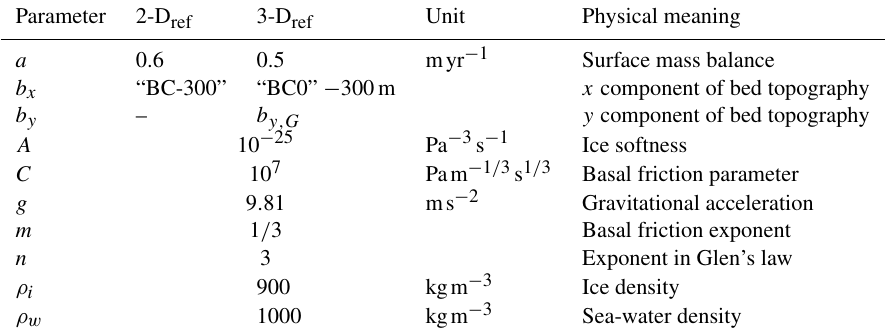
Table 1. Parameter values as prescribed in the unscaled reference simulations for the flow-line setup (2-D) and the three-dimensional channel setup (3-D), respectively. For the scaling experiments the bed geometry ( b x and b y ) and the parameters a , A and C are multiplied with the scaling ratios from to Table 2. The terms “BC-300” and “BC0” refer to the bed geometries described in Feldmann and Levermann (2015a) and b y,G refers to y component of the bed topography used in Gudmundsson et al. (2012).